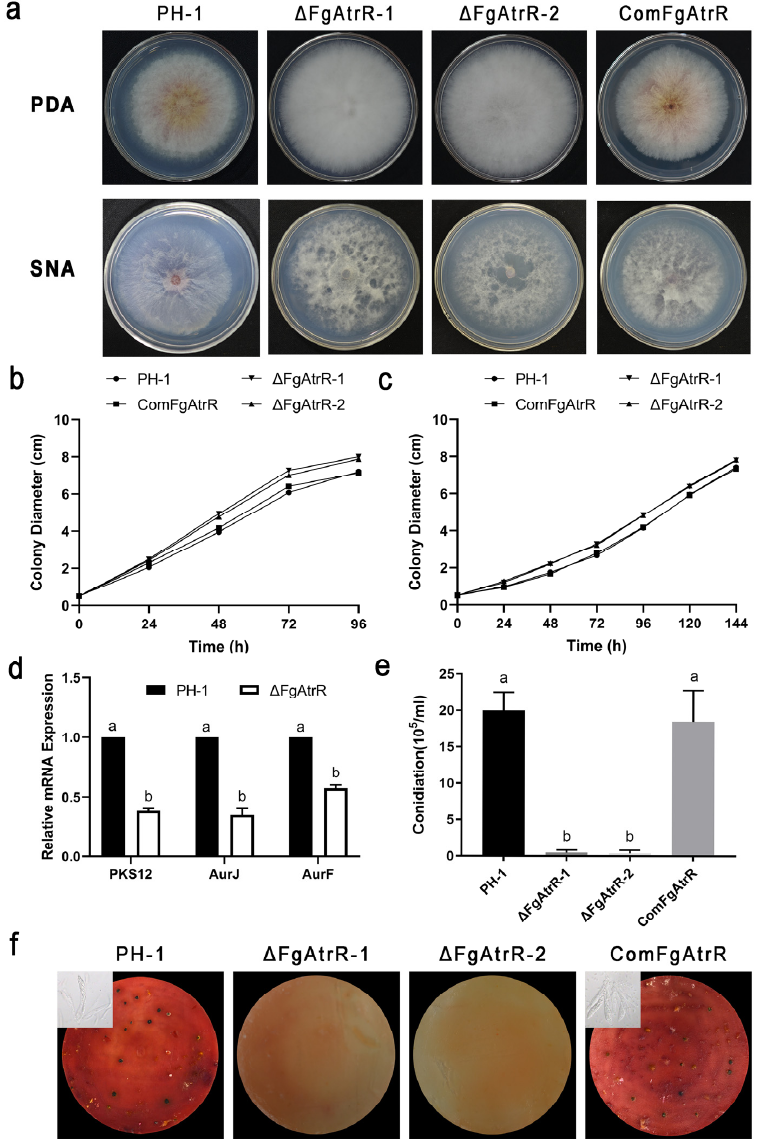
Figure 2. FgAtrR is involved in vegetative growth, pigmentation, and asexual and sexual reproduc- tion in F. graminearum . ( a ) Colony morphology of the wild-type strain PH-1, the Δ FgAtrR mutants, and ComFgAtrR strain. Strains were grown on PDA plates at 25 °C for 4 days. ( b ) The radial growth rate on PDA plates of the wild-type strain PH-1, Δ FgAtrR, and ComFgAtrR. These strains were cultured on PDA plates for 4 days at 25 °C, and the colony diameters of each strain were measured every 24 h. ( c ) The radial growth rate on SNA plates of the wild-type strain PH-1, Δ FgAtrR, and ComFgAtrR. These strains were cultured on PDA plates for 6 days at 25 °C, and the colony diame- ters of each strain were measured every 24 h. ( d ) Relative expression levels of pigment biosynthesis- related genes PKS12 , AurJ , and AurF in each strain. The total RNA of each strain was extracted from mycelia collected after 48 h of incubation at 25 °C in PDB broth. The actin gene was used as the internal control, and the expression level of each gene in PH-1 was arbitrarily set to 1. ( e ) Perithecia and ascospore formation. Strains were first cultured on carrot agar for 7 d and then mock-fertilized to induce sexual reproduction using Tween 60 solution. Perithecia formation was examined after incubation for an additional 3 weeks. ( f ) Conidia production of each strain. Conidia were harvested from the CMC cultures after incubation at 25 °C and 180 rpm for 4 days. All experiments were repeated three times with three replicates each time. Linear bars denote standard errors of three experiments. The different letters on the bars indicate a significant difference at the p < 0.05